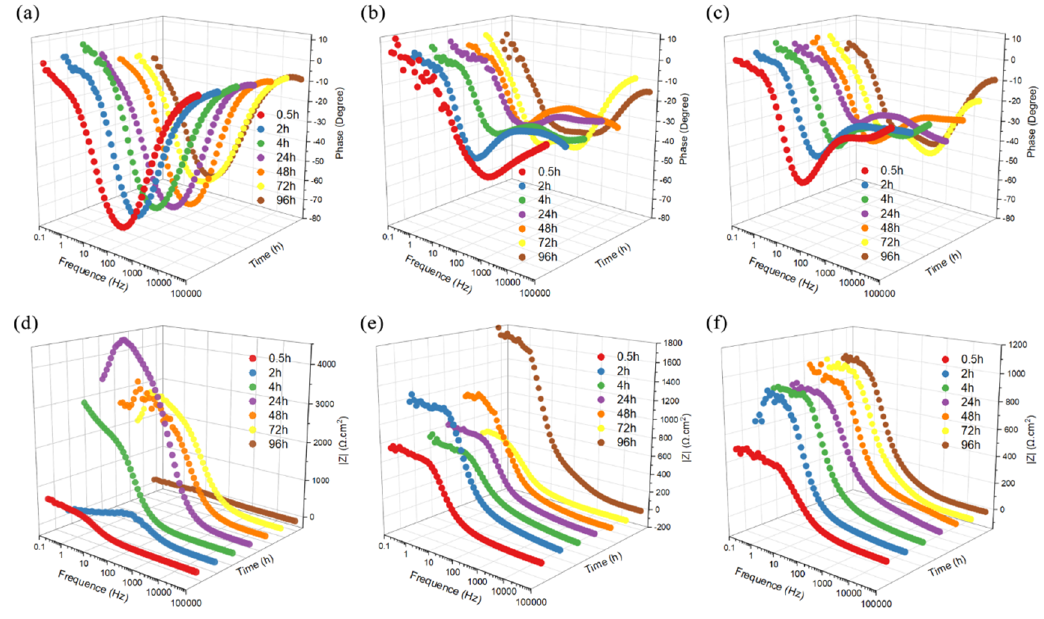
Figure6. ( a , d )Bode-phaseandBode-impedanceplotsofbareMg, ( b , e )Bode-phaseandBode-impedance Figure 6. ( a , d ) Bode-phase and Bode-impedance plots of bare Mg, ( b , e ) Bode-phase and Bode- plots of V 2 O 5 / Mg, and ( c , f ) Bode-phase and Bode-impedance plots of PPy / V 2 O 5 / impedance plots of V 2 O 5 /Mg, and ( c , f ) Bode-phase and Bode-impedance plots of PPy/V 2 O 5 /Mg.